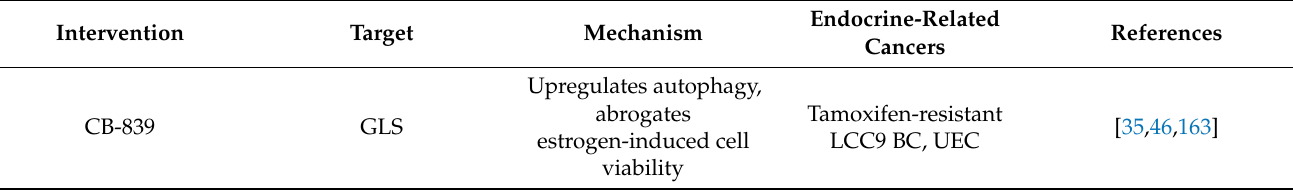
Table 3. Drug intervention in endocrine-related cancers.